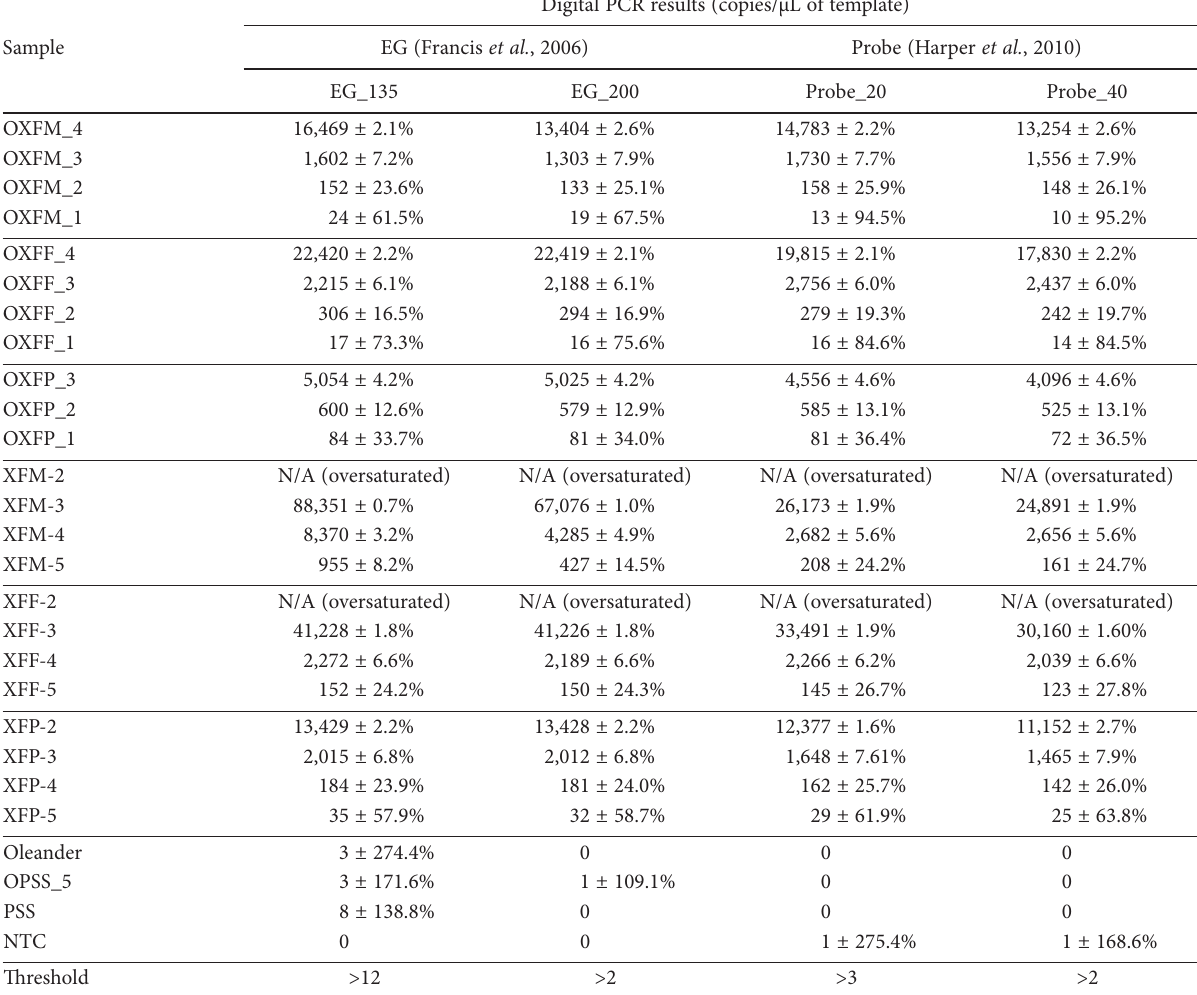
Table 3. Results of dPCR assays on the first set of samples, positive and negative controls. The table reports the target copy number/µL for each sample, the error is calculated as a CI of 95%. The columns report the results obtained with either the EG or Probe method with the two considered thresholds. Copy number was rounded to the closest unit. The error is rounded to the closest decimal. Digital PCR results (copies/µL of Sample